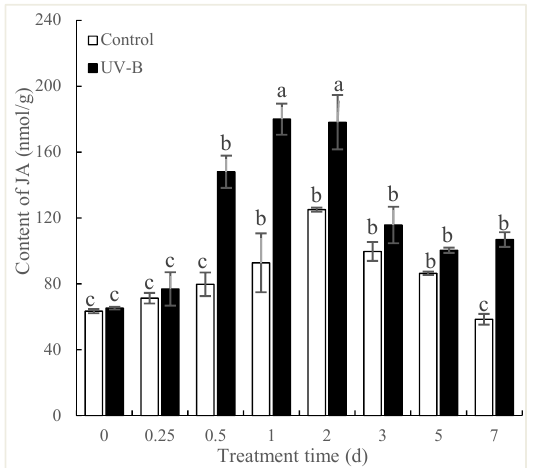
Figure 3. E ff ects of UV-B irradiation on JA content of P. quinquefolius roots. The P. quinquefolius roots that were irradiated with 4 kJ / m 2 UV-B for 5 h were taken for measuring NO and JA contents during a 21-day postharvest drying process. Data are means ± SE of three replicates. Di ff erent letters indicate significantly di ff erent values according to one-way ANOVA followed by Student–Newman–Keuls tests ( p < 0.05).